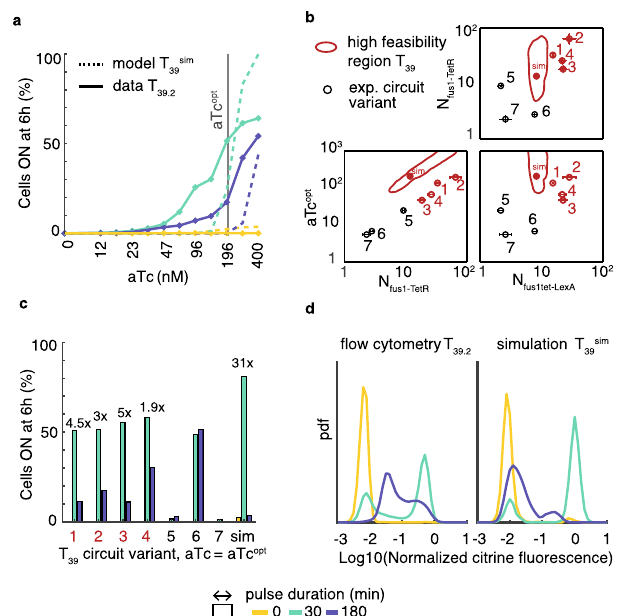
Fig. 6 Decoder validation and performance. a Responses at 6 h to 0, 30, or 180 min pulses (colors) of 1 μ M α -factor for T 39.2 at varying aTc concentrations as determined experimentally by fl ow cytometry (see Supplementary Fig. 9a for all circuits). All fl ow cytometry measurements include at least 4000 cells after gating. Experimental data (solid lines) are complemented by model predictions (dashed lines) for an optimal T 39 implementation (T 39 sim , see Supplementary Methods). b Experimentally determined copy numbers for seven implemented variants of T 39 (mean ± s.d., n = 3 technical replicates) and optimal aTc concentrations (aTc opt ; estimated for T 39.1 – 4 (red open symbols) and extrapolated for T 39.5 – 7 (black open symbols; see also Supplementary Fig. 9b)). Red contour line: predicted region of high feasibility. Filled red symbol: copy numbers and aTc concentration for T 39 sim . c Responses at 6 h for T 39.1 – 7 and for the optimal simulated circuit at aTc opt . Numbers above bars: fold-changes in responses to 30 min pulses relative to 180 min pulses. d Distributions of single-cell responses of T 39 (pdf: probability density function) to input pulses at aTc opt , determined experimentally as in Fig. 5b (left) and predicted computationally (right; equivalent